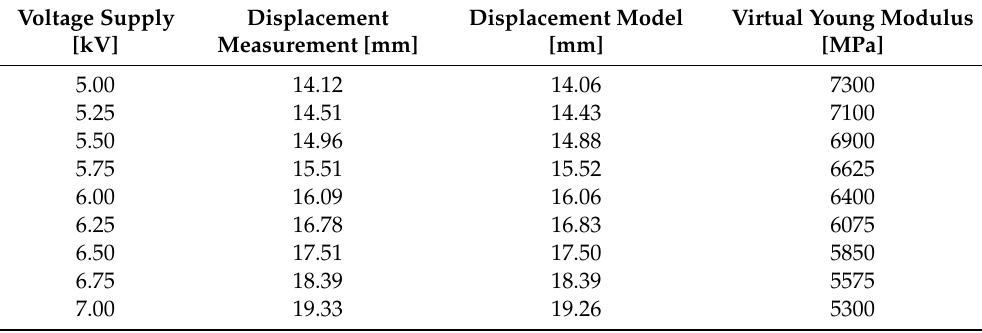
Table 5. The comparison of the displacements for di ff erent voltage supply and load force 1.23 [N]. Voltage Supply